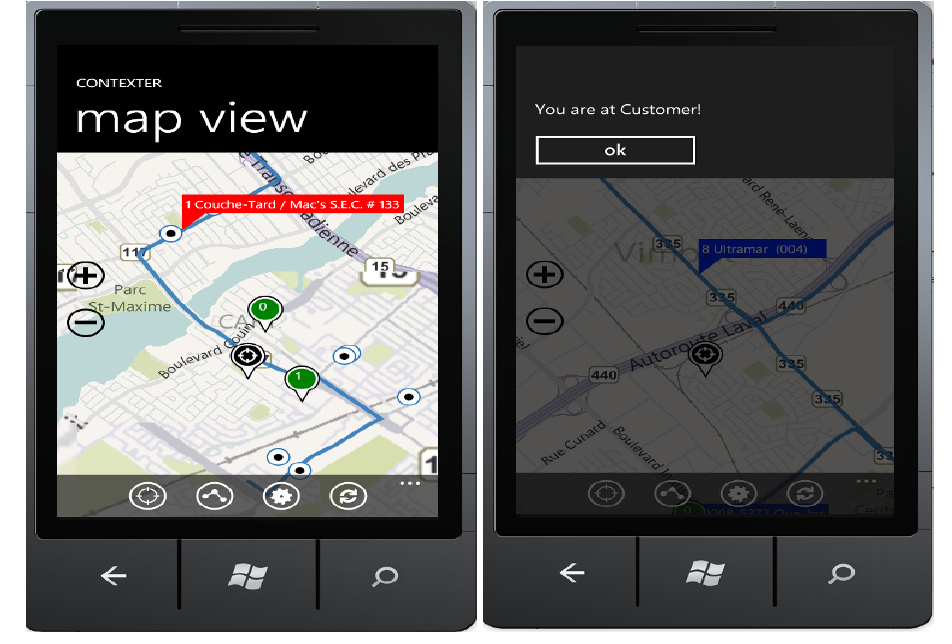
Figure 12. Phone Application-1